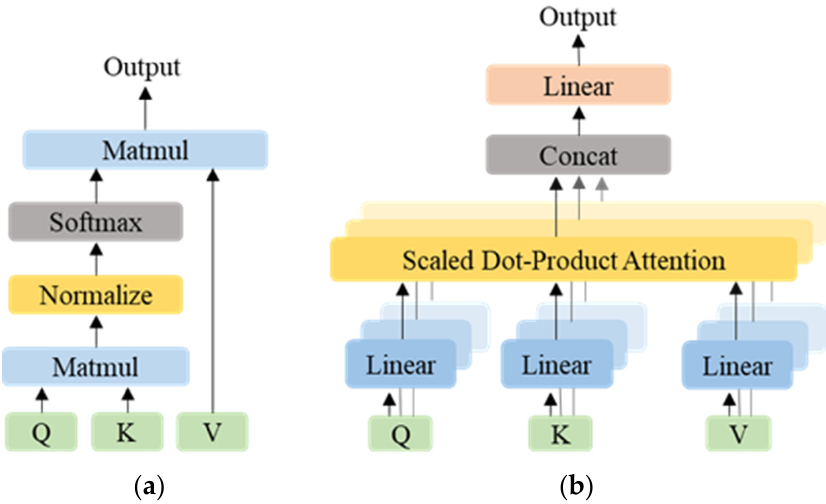
Figure 4. The illustration of self-attention in Transformer. ( a ) The self-attention; ( b ) the multi-head self-attention.